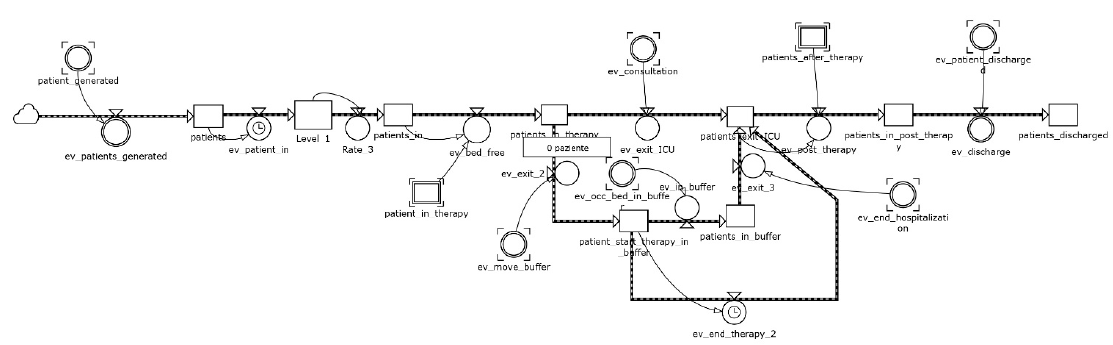
Figure 8. The patient module for the cell design scenario.